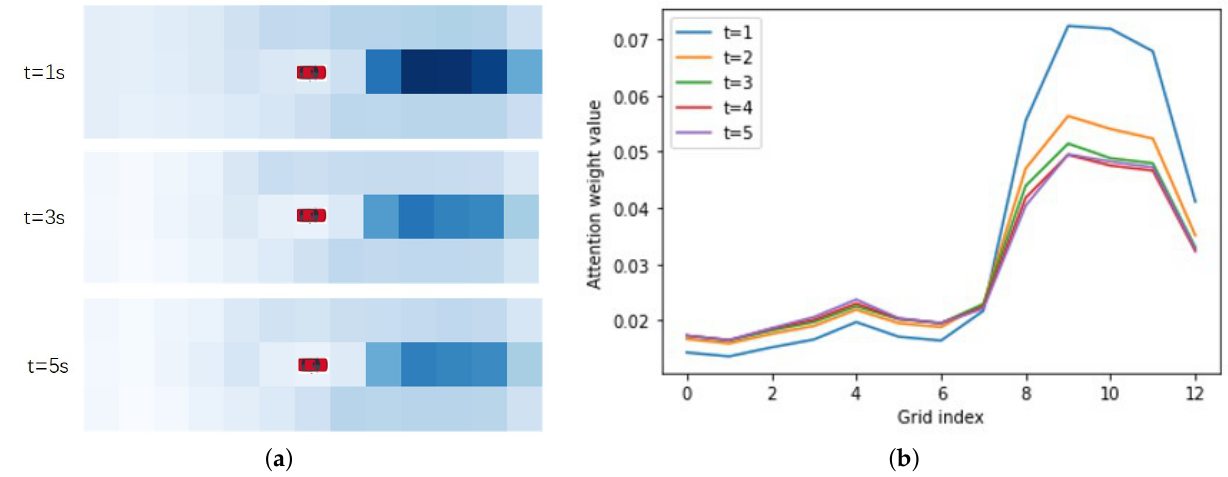
Figure 4. Visualization results of average weights of test samples: ( a ) attention distribution when prediction time is 1 s, 3 s, and 5 s (the darker grid indicates the greater weight); ( b ) attention weight (middle lane) in the horizon of 5 s (the black dotted line is the research object’s